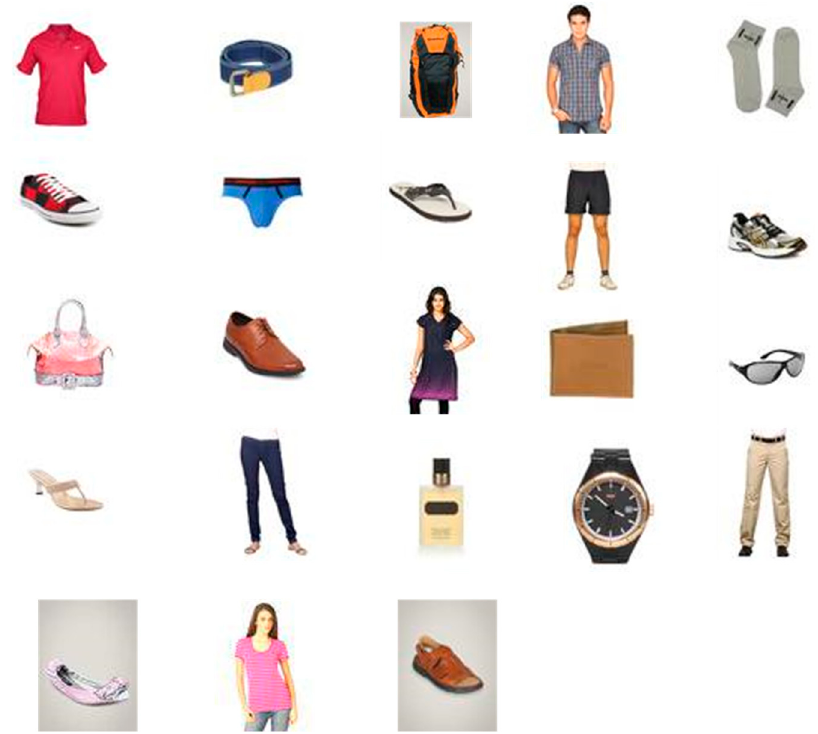
Figure 3. Sample images from the Fashion Product Images Dataset.